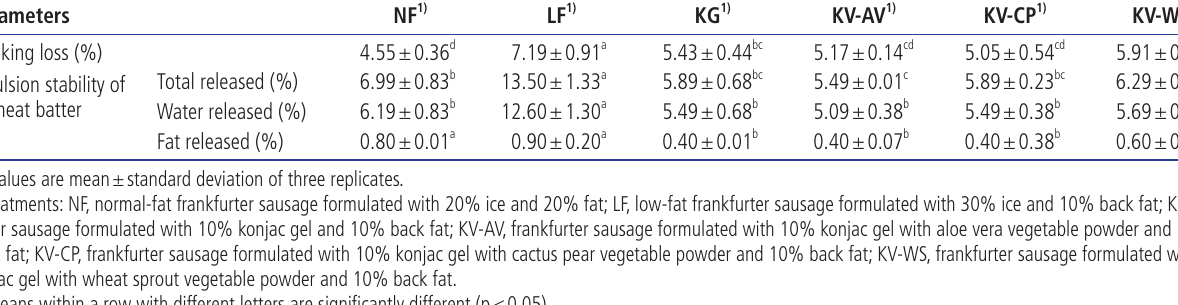
Table 5. Cooking loss and emulsion stability of frankfurter sausages